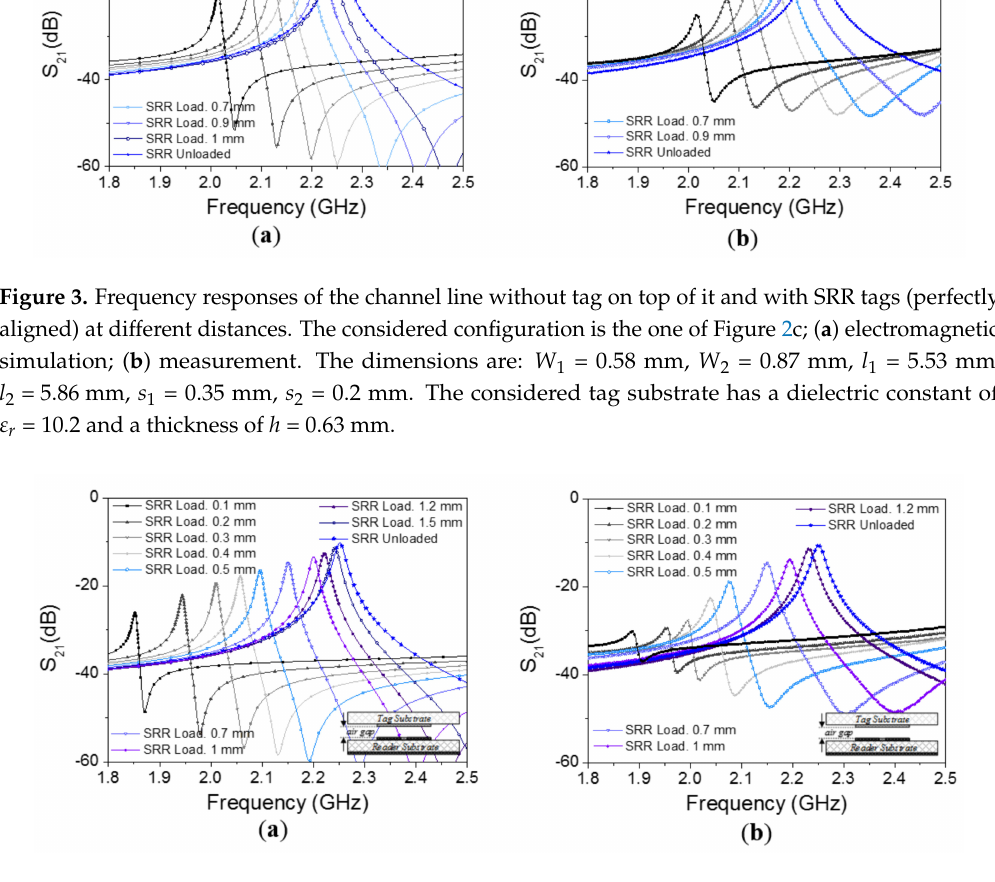
Figure 4. Frequency responses of the channel line without tag on top of it and with SRR (perfectly aligned) at different distances. The considered configuration is that of Figure 2d; ( a ) electromagnetic simulation; ( b ) measurement. The dimensions and tag substrate are those indicated in the caption of Figure